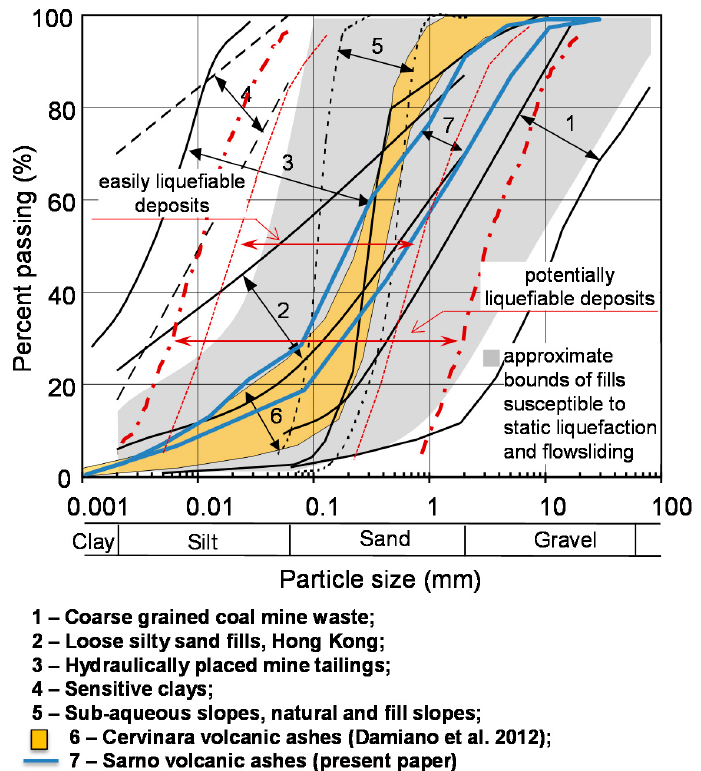
Figure 2. Grain-size distributions of Sarno and Cervinara ash soils compared with liquefiable soil deposits.